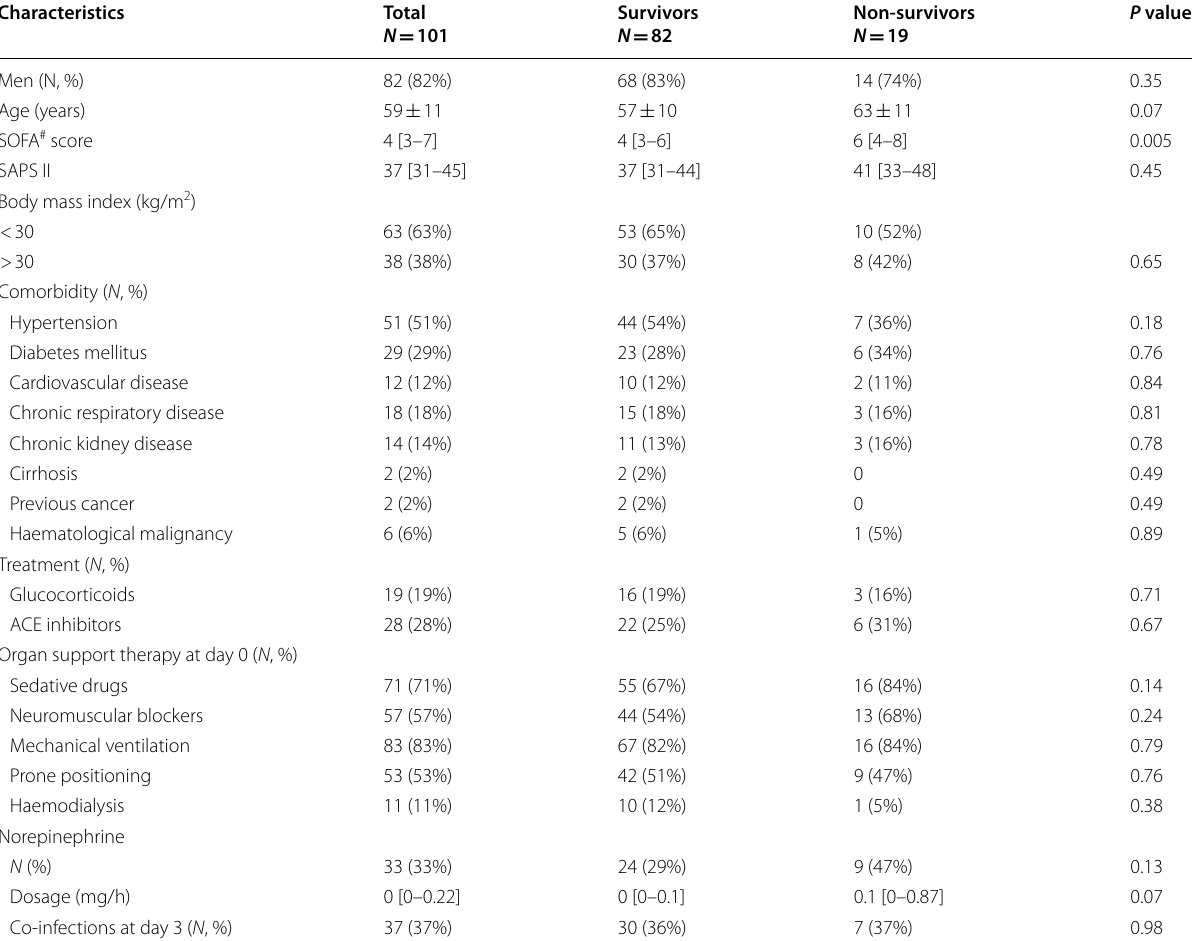
Table 1 Characteristics of included ICU patients with SARS-CoV-2 infection according to 60-day outcome